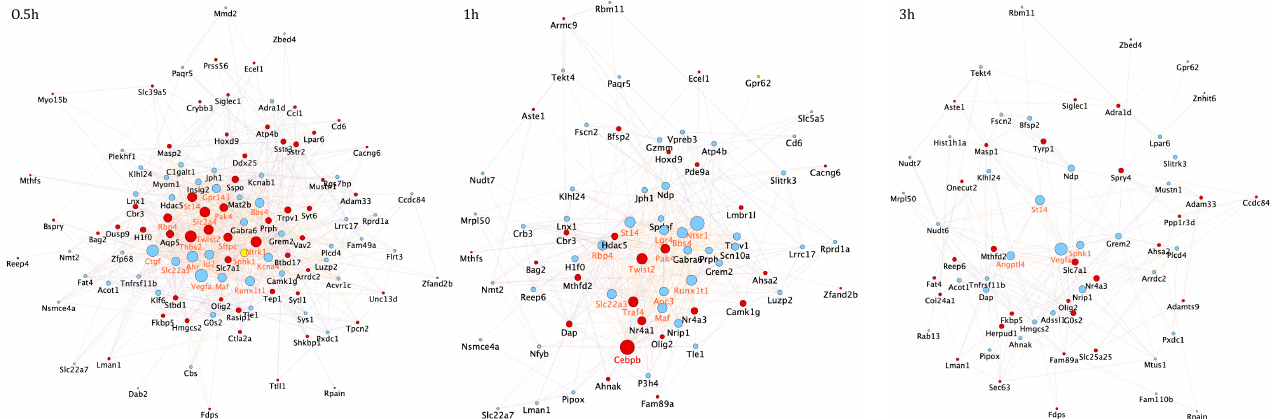
Figure 4. Temporal specific core set genes-related PPI networks. The three time-point (0.5, 1 and 3 h) specific core set genes-related PPI networks were constructed using the STRING website and visualized by Cytoscape (version: 3.8.2,) by mapping the “degree parameter” to node size. As the node size increased, the value of the connectivity degree of node genes increased. Light blue/red nodes indicate, respectively, down-/upregulated genes following treatment with all GFs compared with apoptotic CGNs (K5). Differently colored “edges” indicate the type of evidence supporting each interaction: dark purple, co-expression; light purple, physical interaction; light blue, co-localization; light green, shared protein domain; orange, predicted; grey, other.